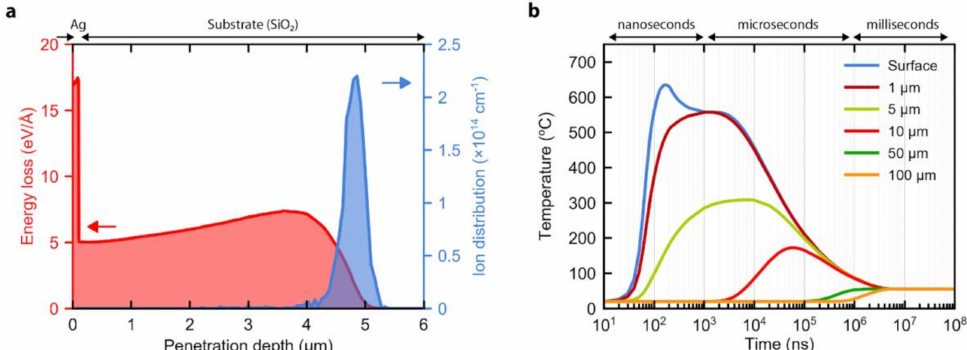
Figure 1. ( a ) Protons energy loss (left, y -axis) and distribution (right, y -axis) within the sample. ( b ) Intense pulsed ion beam irradiation induced heat transfer in Ag / SiO 2 structure, showing near-surface annealing